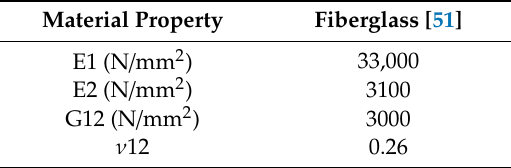
Table 5. Material properties of fiberglass plates.